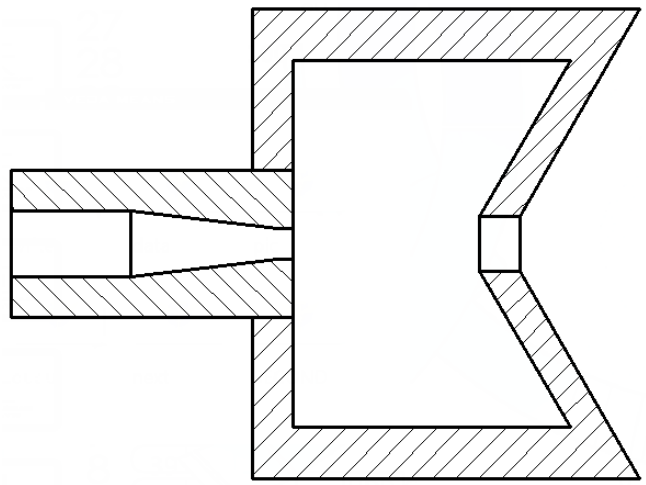
Figure 1. Schematic diagram of the 120° ‐ impinging edge Helmholtz nozzle.